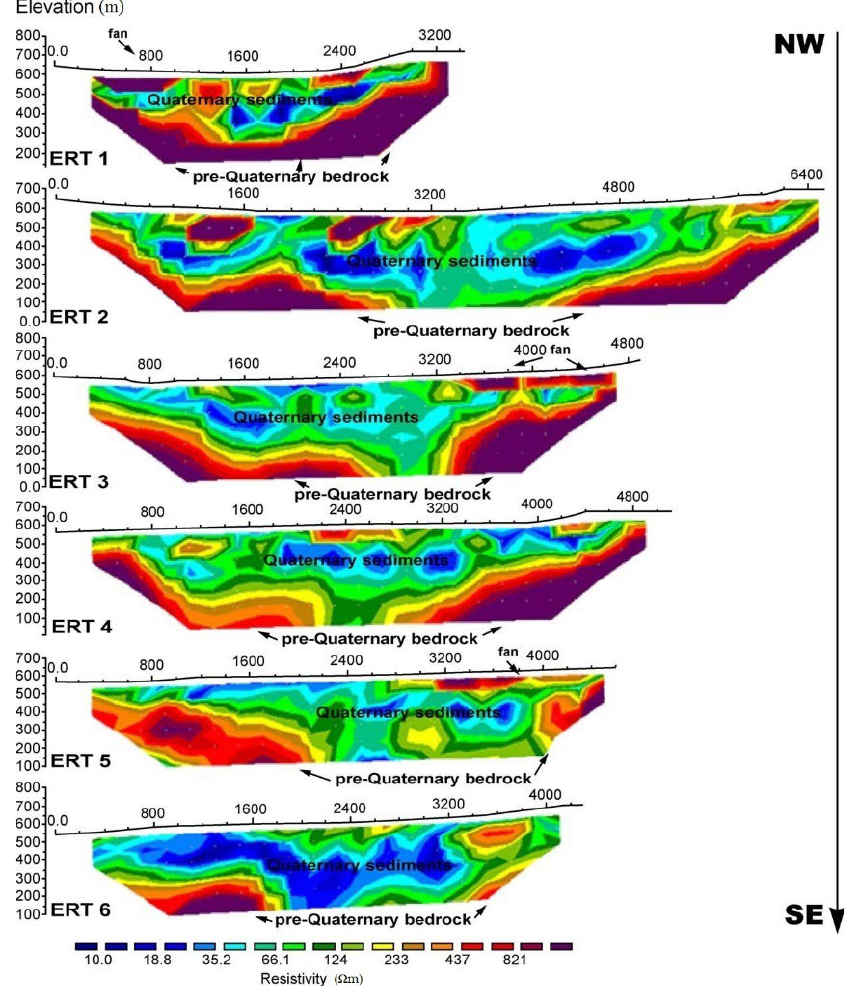
Figure 6. ERTs carried out in the northernmost (ERT 1, 2 and 3) and southernmost (ERT 4, 5 and 6) part of the High Agri Valley basin. The relatively high resistivity contrast between the shallow alluvial deposits and the pre-Quaternary bedrock highlights the geometry of the fault-bonded basin. The resistivity zones on the shallow layers are associated with the presence of fans on the flanks of the basin. The shape of the basin floor is asymmetric and the maximum sediment thickness occurs along the northeastern margin (Reprinted with permission from [32], Copyright (2004), Elsevier).